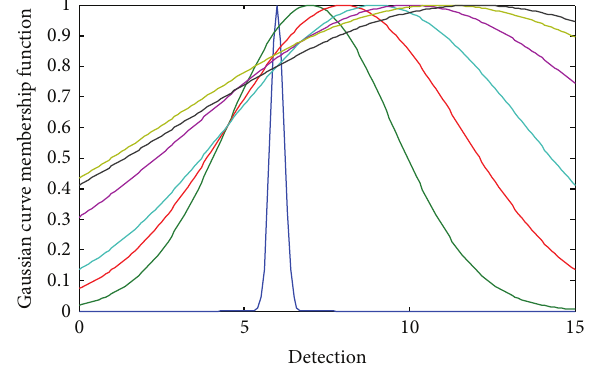
Figure 4: Gaussian curve membership function for Detection.